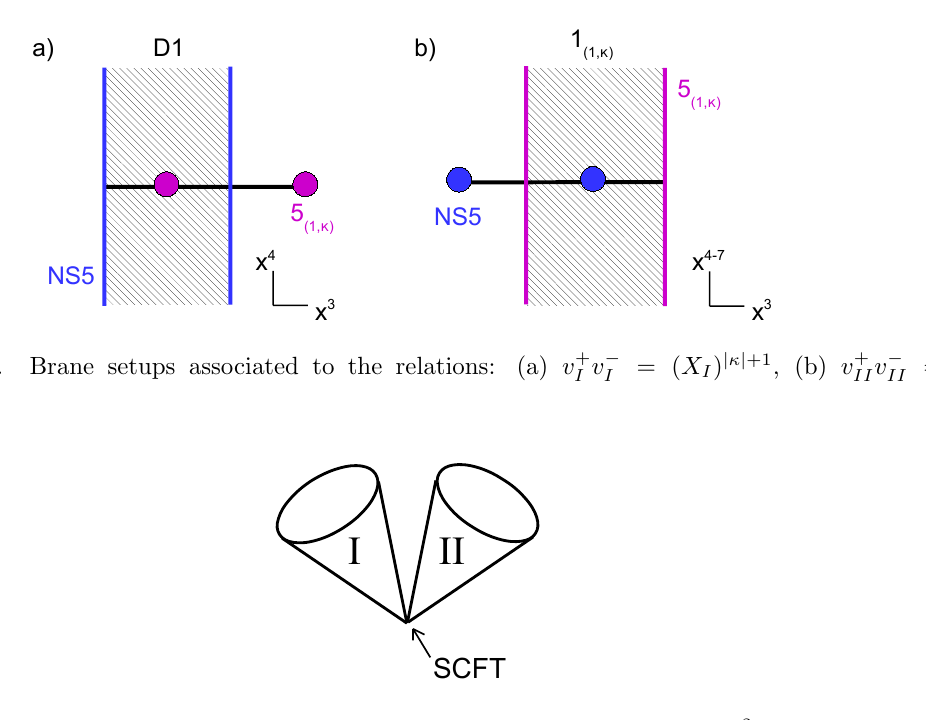
Figure 17 . Moduli space of the U(1) (cid:20) (cid:2) U(1) (cid:0) (cid:20) (cid:2) U(1) (cid:20) theory. There are two ( C 2 = Z meeting at the origin (SCFT